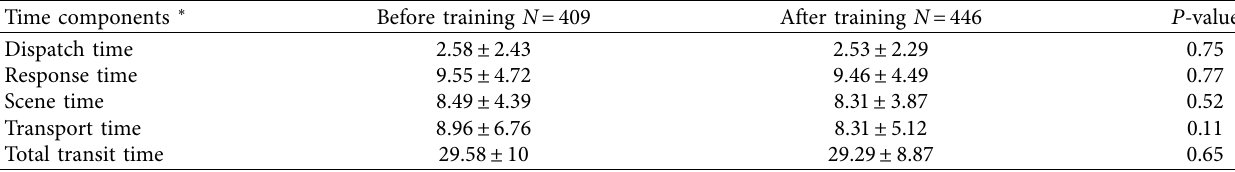
Table 1: Comparison of first-aid transit time before and after training.